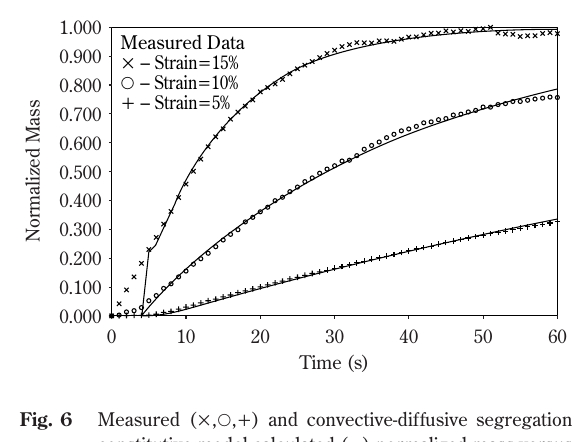
Fig. 6 Measured ( (cid:1) , (cid:1) , (cid:6) ) and convective-diffusive segregation constitutive model calculated ( (cid:4) ) normalized mass versus time data (cid:4) Size Ratio (cid:5) 10.9:1, Cycle Speed (cid:5) 0.75 Hz, Bed Depth (cid:5) 7.62 cm